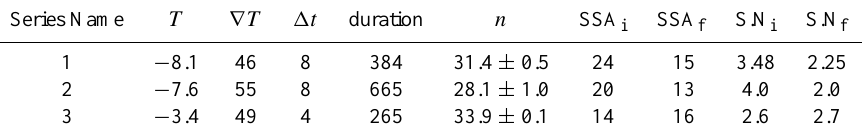
Table 1. Experimental conditions and structural evolution of the snow. T : mean temperature of sample ( ◦ C ) , ∇ T : temperature gradient (Km − 1 ), 1t : period between CT-scans (h), duration: total time of experiments (h), n : solid volume fraction (%) (Fig. S1), SSA i , SSA f : specific surface area at the beginning and end of the experiments (mm − 1 ) (Fig. S2), S.N i , S.N f : number of ice structures per length (mm − 1 ).